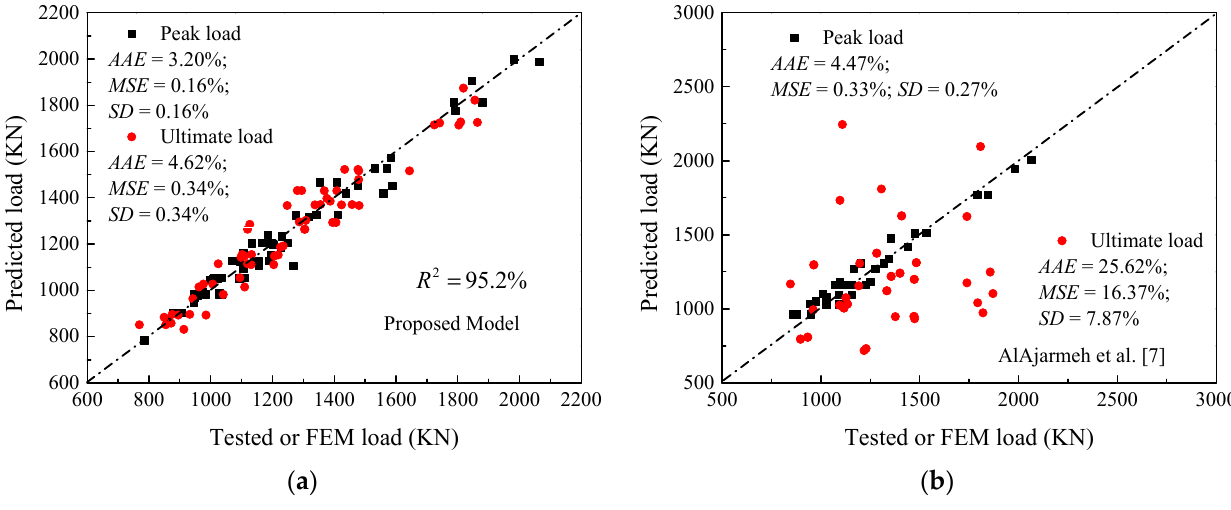
Figure 18. Performance of the proposed and existing models of HCCs: ( a ) Current ANN model; ( b ) AlAjarmeh et al.’s [7] analytical model.